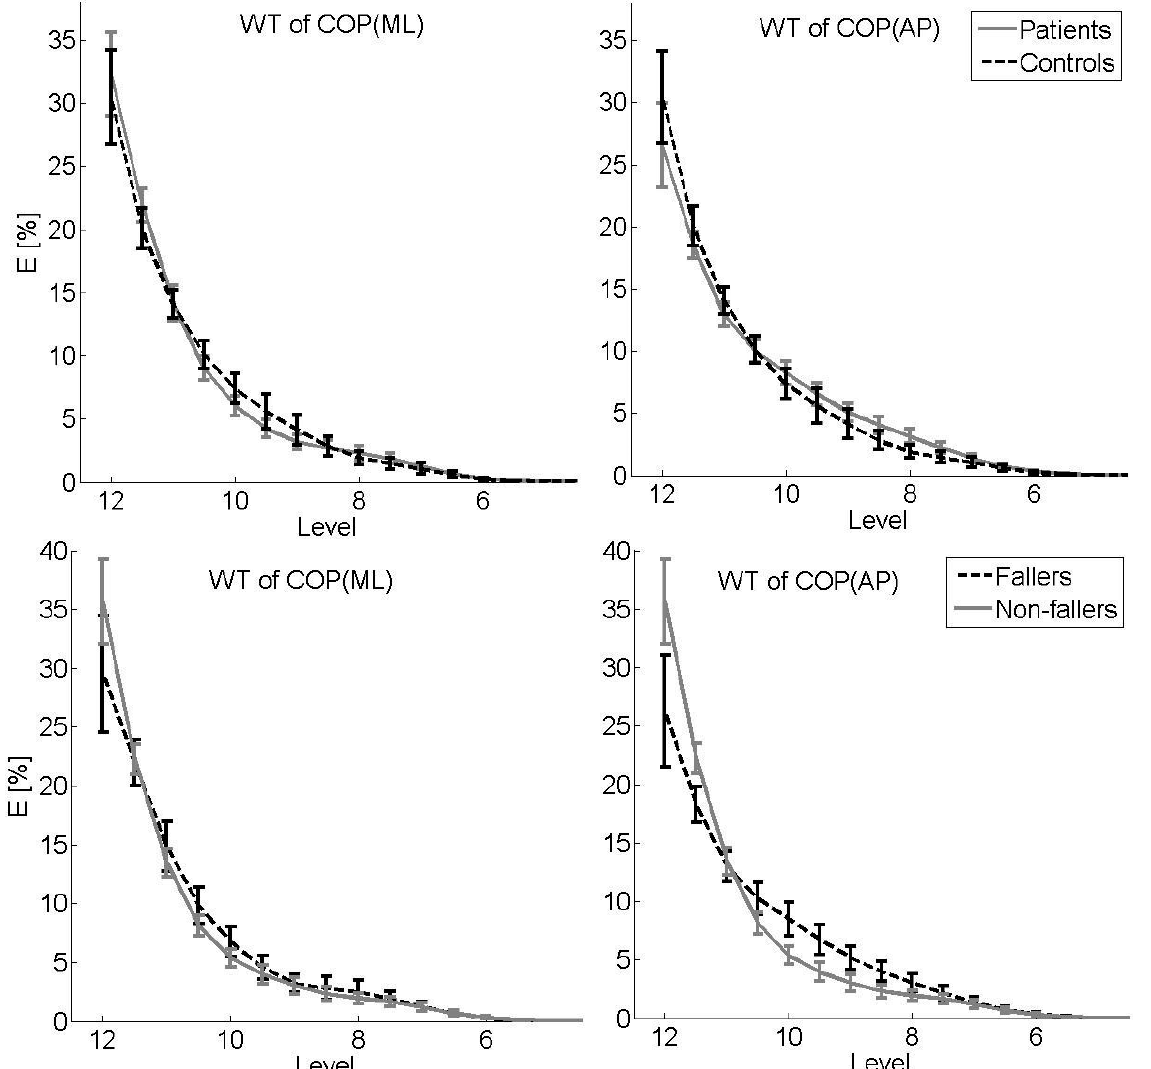
Figure 2. Energy (E) as a percentage of total energy for levels j = 12, …, 5 for COP (ML) ( left panel) and COP (AP) ( right panel) for controls vs. patients ( upper panel) and fallers vs. non-fallers ( lower panel). Sample means with 95% confidence intervals are shown. Level j corresponds to a frequency of f = 80/2 j Hz, e.g., j = 12 = ̂ f = 0.02 Hz. WT = wavelet transformation, COP = center of pressure, ML = medial–lateral, AP = anterior- posterior.